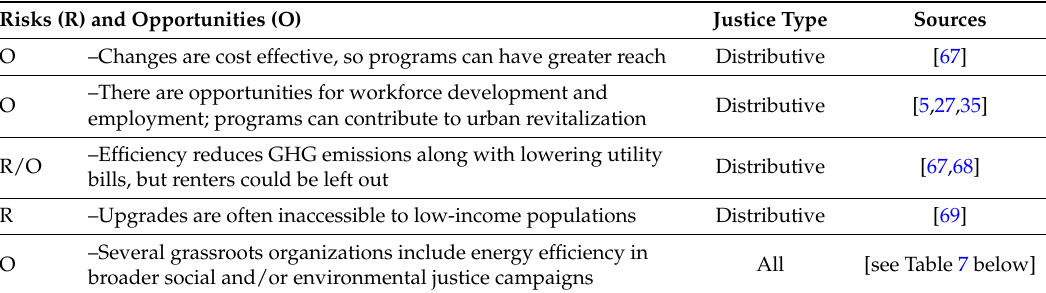
Table 6. Equity and justice potential from energy